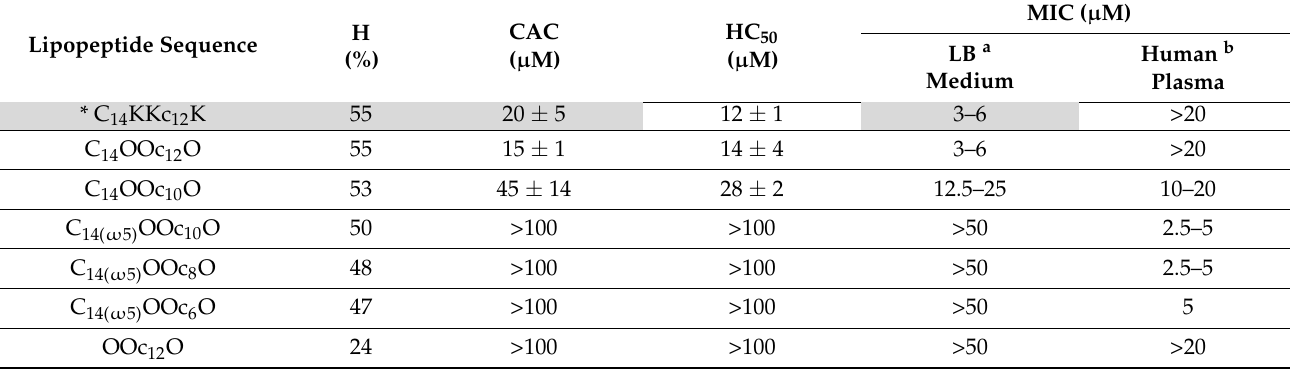
Table 1. Biophysical attributes of relevant lipopeptide analogs.